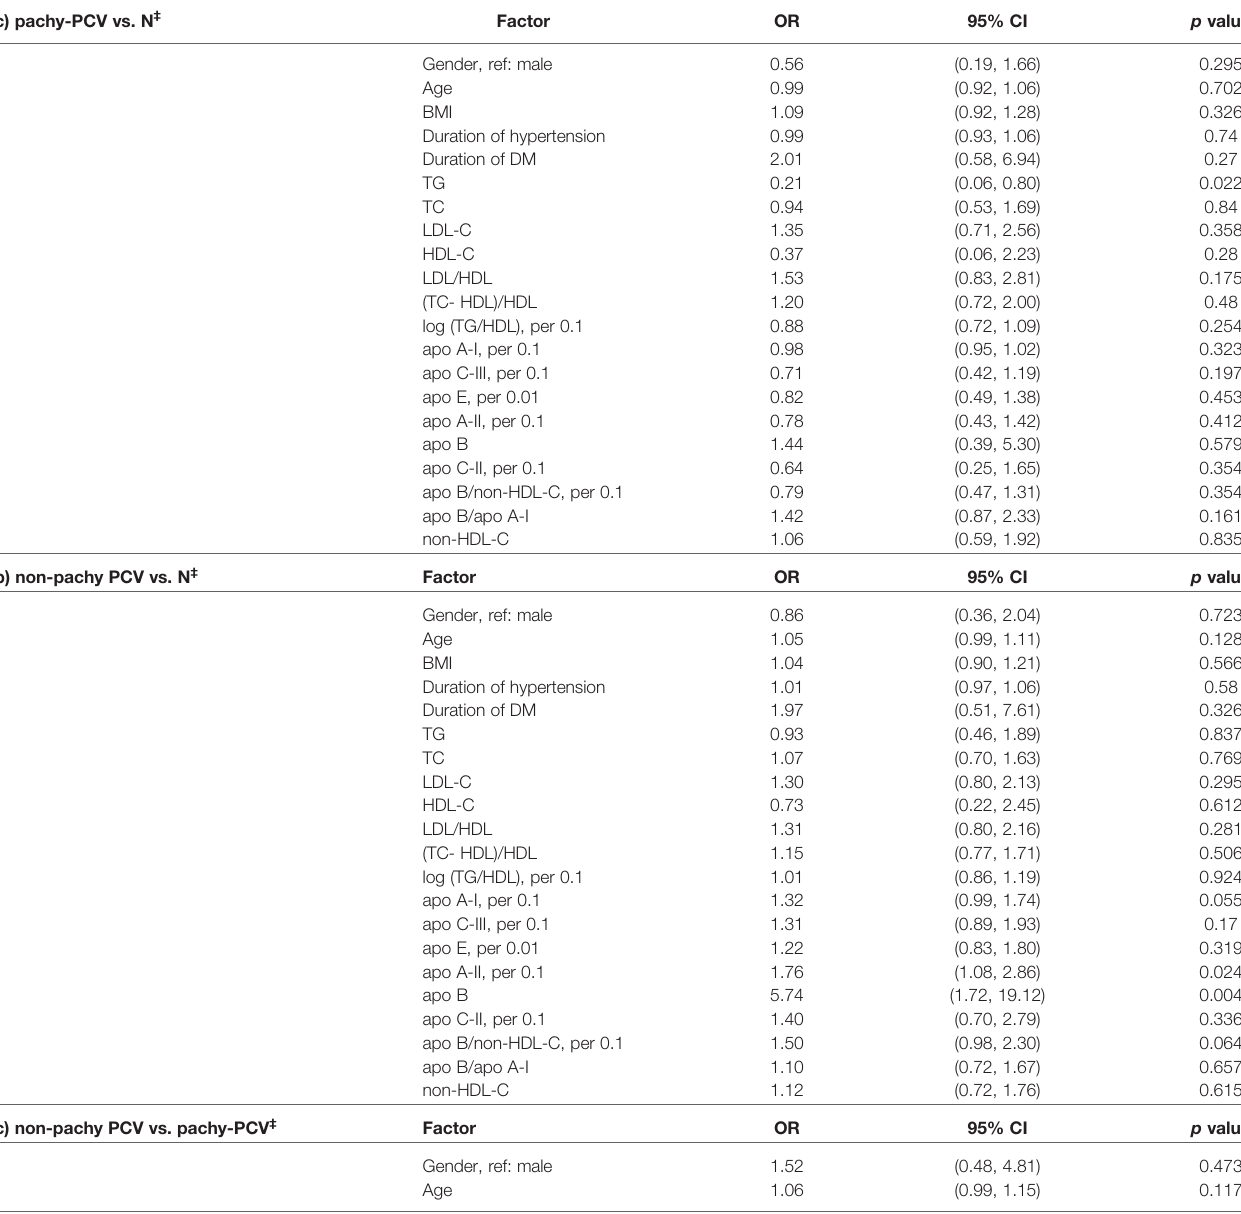
TABLE 3 | Comparisons of the variables between the sub-groups (pachy and non-pachy) of PCV and control group by univariate logistic regression analysis. (c) pachy-PCV vs. N